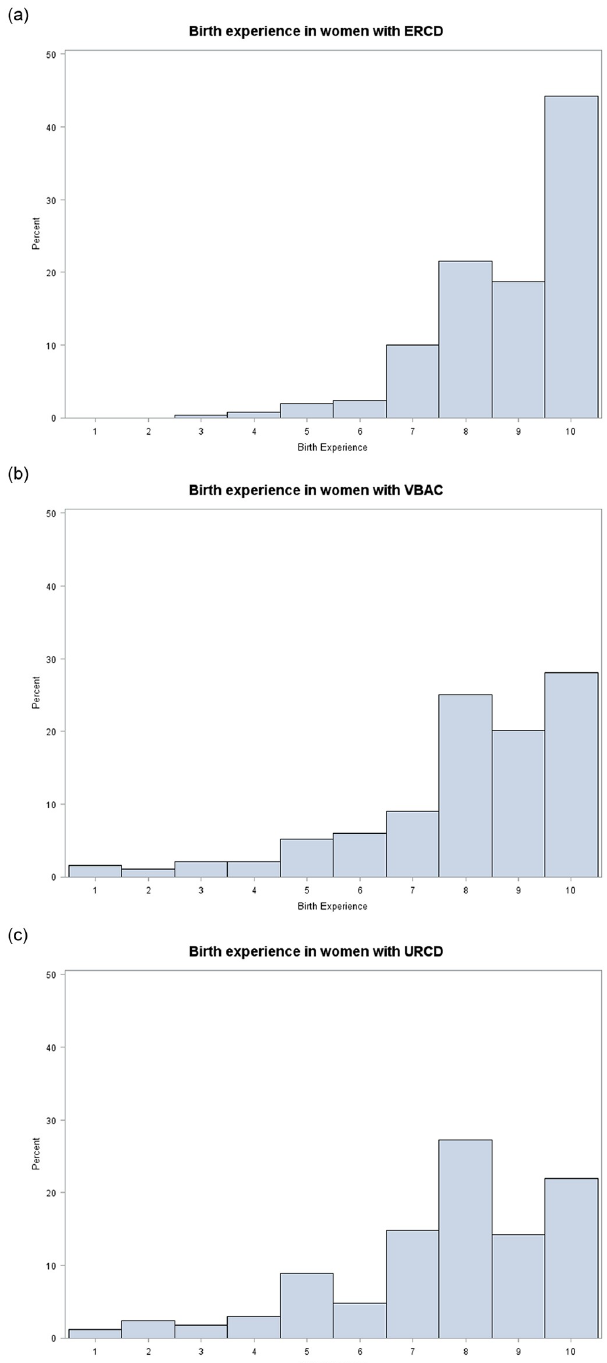
Fig 2. Histogram of birth experience after 2 nd birth by mode of delivery in 2 nd birth; Elective repeat cesarean delivery (ERCD), vaginal birth after cesarean (VBAC) and unplanned repeat cesarean delivery (URCD).